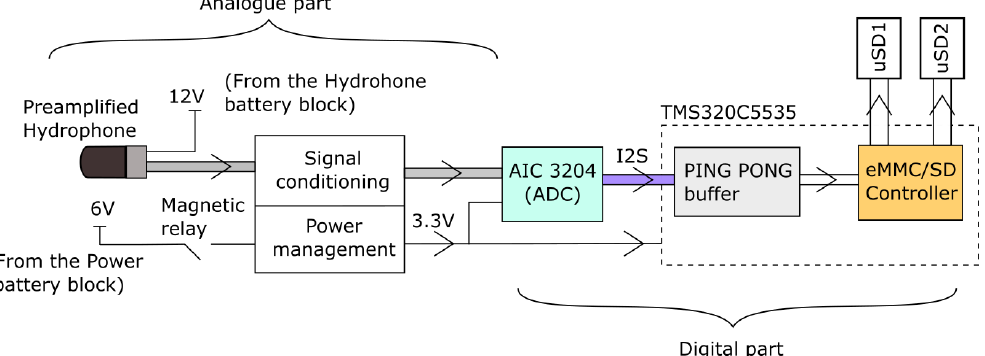
Figure 1. Block diagram of the SAMARUC system. Audio differential signals shaded in grey. I2S bus shaded in